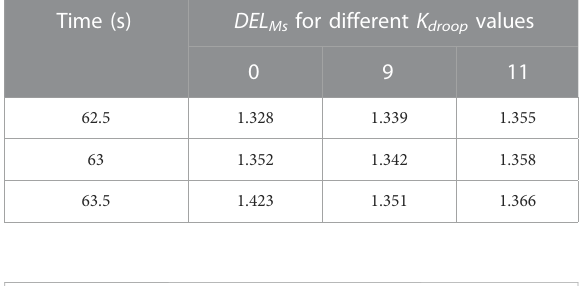
FIGURE 14 DEL tot results under the change in K when the system load increases and decreases by 5% at 35 s.